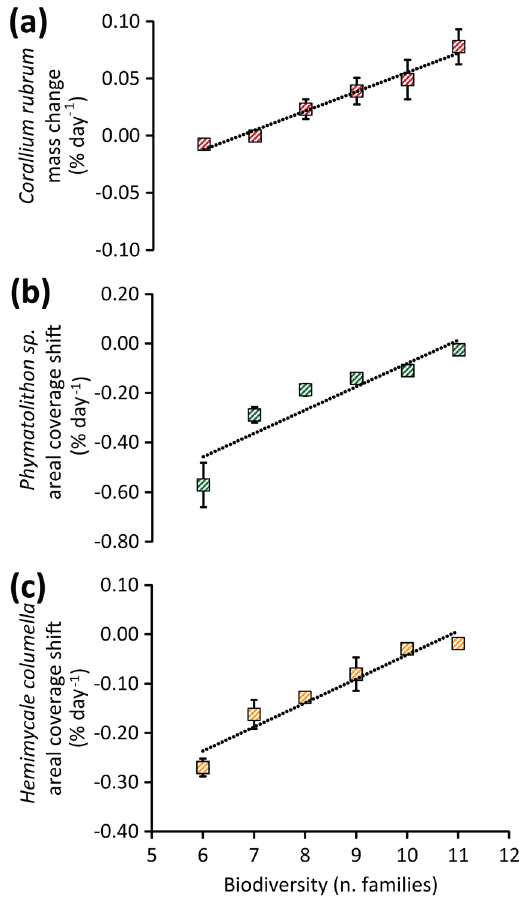
Figure 3. A higher biodiversity reduces the impacts of acidification. For all acidified mesocosms tested in the present study, reported are the positive relationships found between biodiversity (as number of different families contained in the natural coralligenous assemblages tested) and ( a ) the daily changes in mass weight of C. rubrum colonies, ( b ) the daily areal coverage shifts of Phymatolithon sp. (the dominant coralline alga) and ( c ) the daily areal coverage shifts of H. columella (the dominant epilithic sponge). Reported are average values and